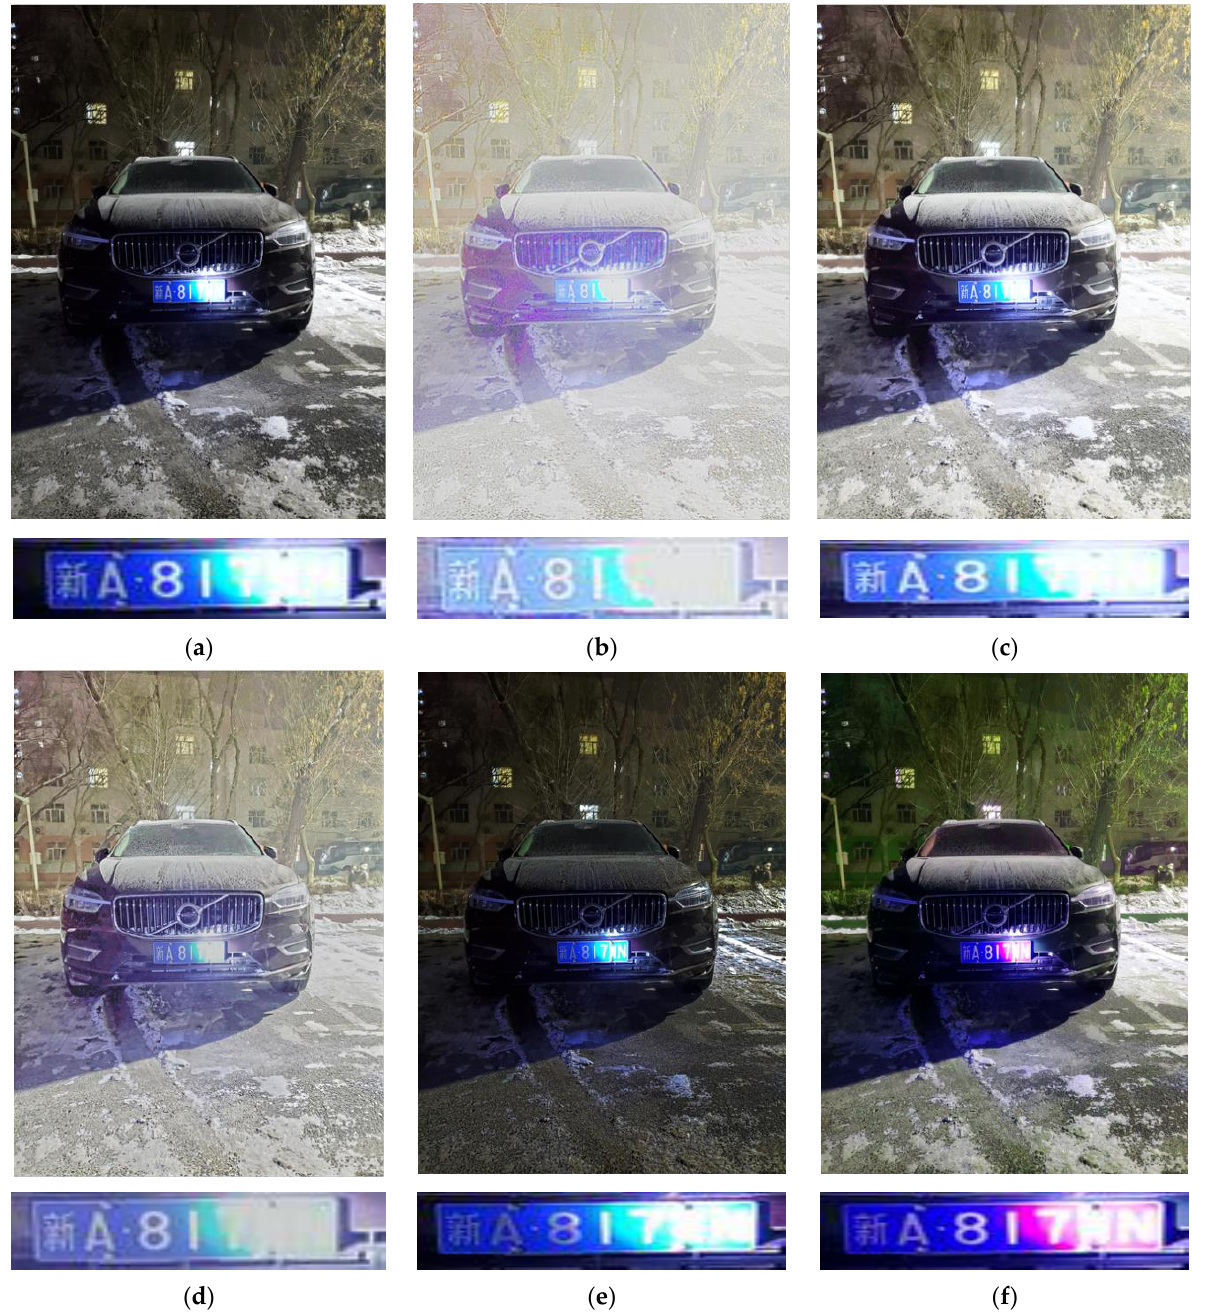
Figure 4. Experimental results: ( a ) original image, ( b ) Hui [35], ( c ) Khan [36], ( d ) Liang [21], ( e ) Xin [37], ( f ) proposed.